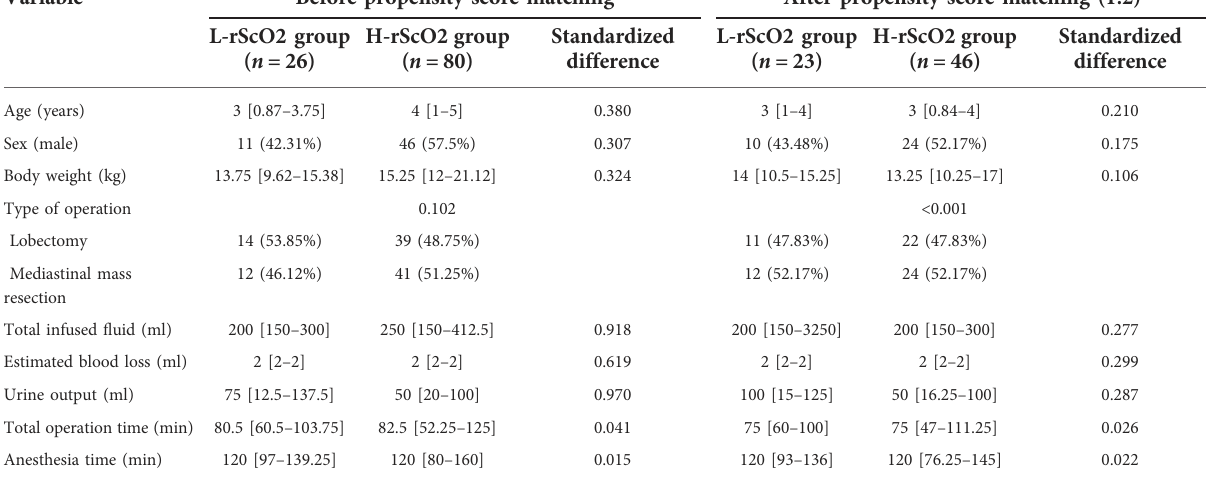
TABLE 1 Baseline characteristics and intraoperative variables of all patients before and after propensity score matching. Data are presented as mean (standard deviation), median (inter-quartile range), or n (%). rScO2: regional cerebral oxygen